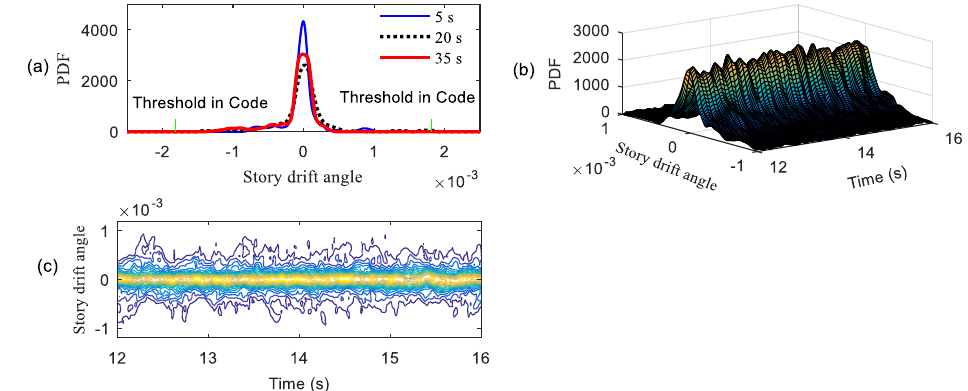
Figure 16. Story drift angles of the third story excited by stochastic simulated seismic ground motions of site IV group 3 (frequent earthquake): ( a ) probability distribution at certain time instants; ( b ) PDF evolution surface; ( c ) contour of the PDF surface.